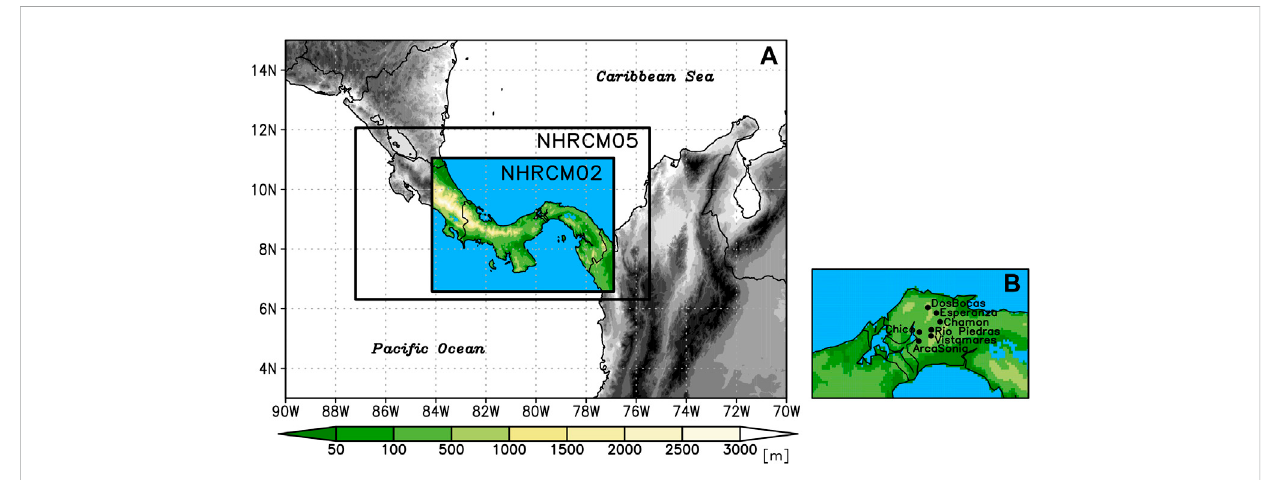
FIGURE 1 Calculation domains for NHRCM05/02 (A) and locations of rain gauge stations (B) . The colors indicate elevation.